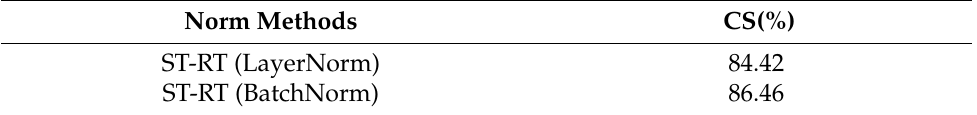
Table 4. Accuracy comparison of the ST-RT models between two normalization methods in ST- RT model.